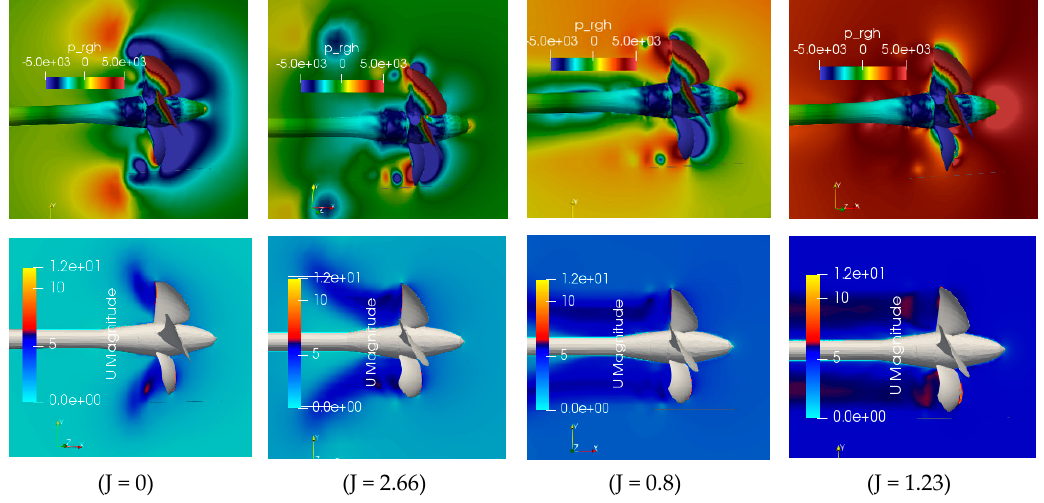
Figure 4. Pressure ( top ) and velocity ( bottom ) contours for different advance coefficients.